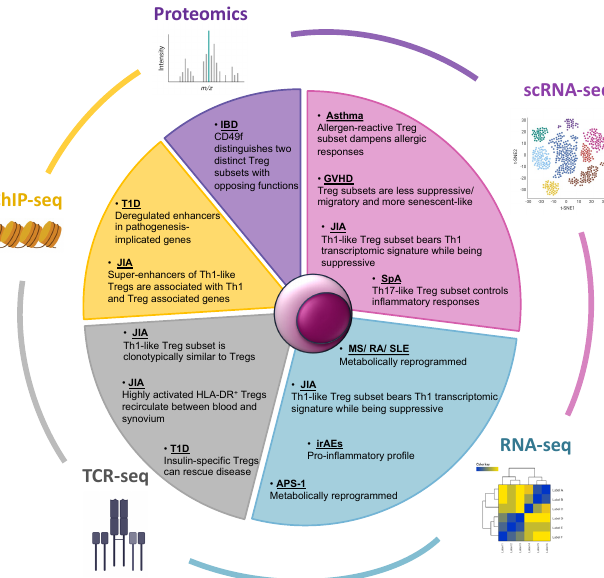
Figure 1. Multi-omics approaches utilized in IMIDs research, focusing on regulatory T cells. The Pie chart depicts omics technologies that have been used to study the contribution of regulatory T cells in the pathology of IMIDs. Predominantly RNA-seq but also proteomic and epigenomic technologies have revealed Treg profiles that are suppressive, pro-inflammatory, or metabolically reprogrammed, as well as distinct Treg subsets across various diseases. scRNA-seq, single cell RNA-seq; ChIP-seq, Chromatin Immunoprecipitation sequencing; TCR-seq, T Cell Receptor sequencing; GVHD, Graft Versus Host Disease; JIA, Juvenile Rheumatoid Arthritis; SpA, Spondyloarthritis; MS, Multiple Sclerosis; RA, Rheumatoid Arthritis; SLE, Systemic Lupus Erythematosus; irAEs, immune related Adverse Events; APS-1, Autoimmune Polyendocrine Syndrome Type I; T1D, Type I Diabetes; IBD, Inflammatory Bowel